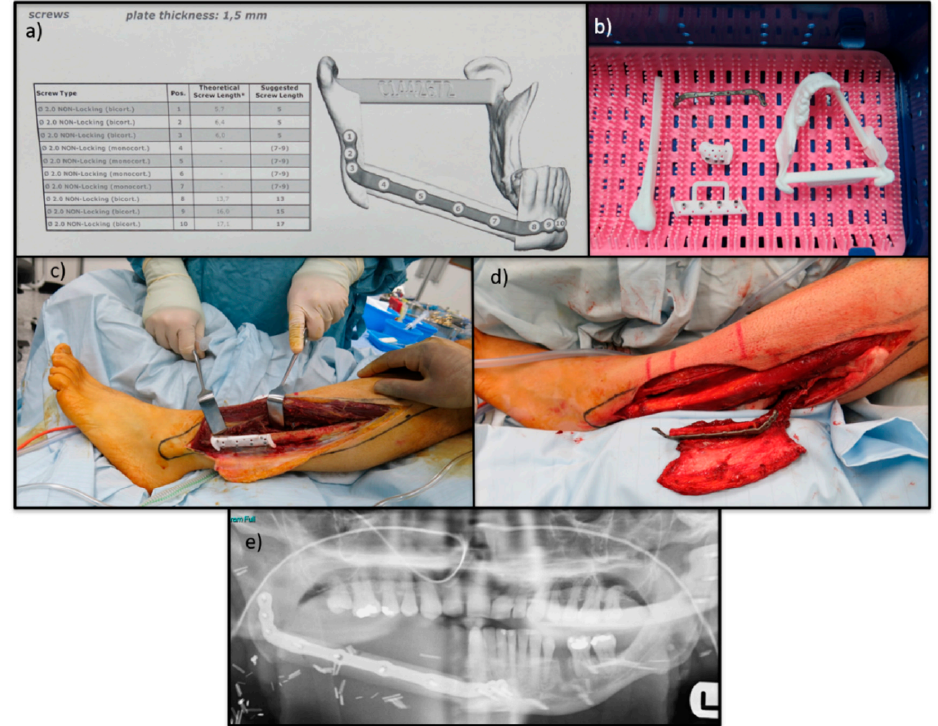
Figure 9. Images show the reconstruction of a mandibular OS. ( a ) Shows the reconstruction plan including the pre-determined screw lengths and locations. ( b ) Shows the 3D cutting guides, 3D model and the custom reconstruction plate. ( c ) Shows custom cutting guide on free fibula osseocutaneous flap. ( d ) custom reconstruction plate attached to free fibular osseocutaneous flap. ( e ) Shows the follow up orthopantomogram with free fibula osseocutaneous flap fixed in